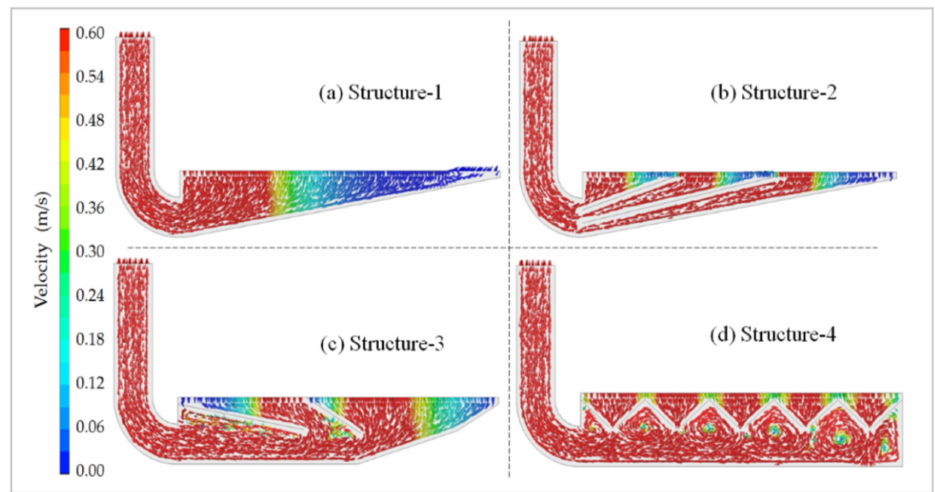
Figure 10. Velocity vector maps for four differently structured